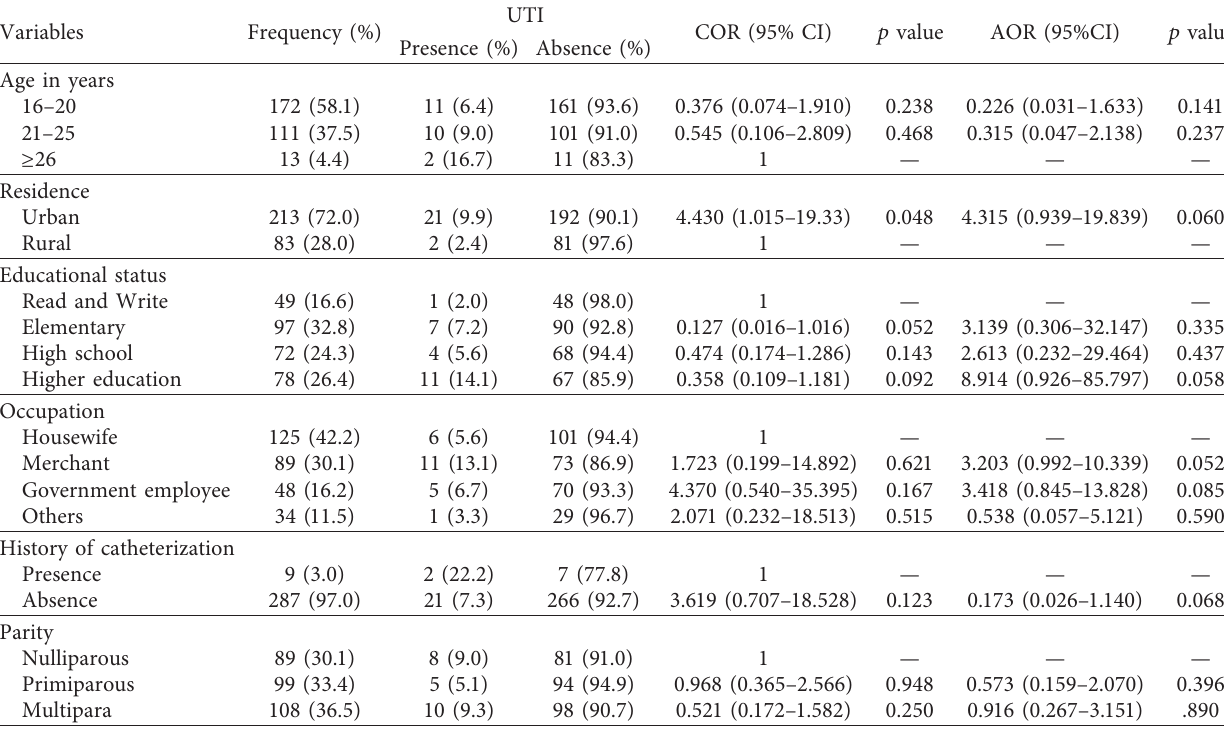
Table 3: Multivariate analysis for the assessment of factors associated with UTI among pregnant women attending ANC at HUCSH, Southern Ethiopia, from March to June 2019.